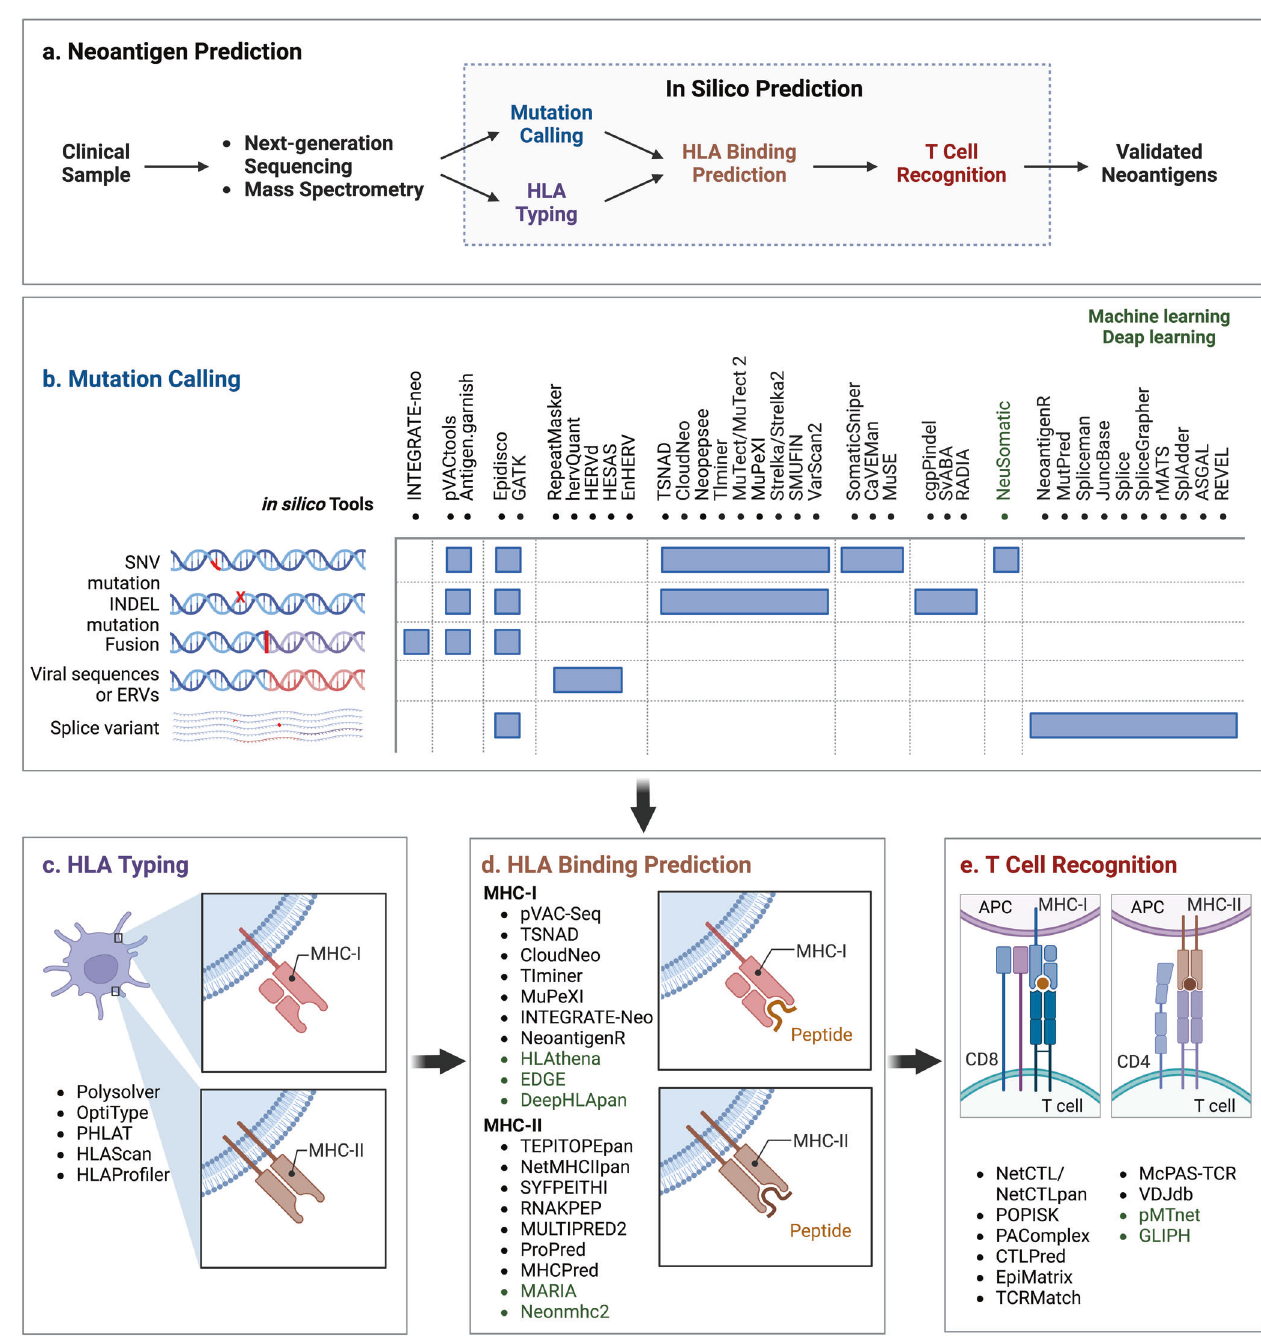
Fig. 3 Computational work fl ow for neoantigen prediction. Current available bioinformatic pipelines for neoantigen prediction from somatic mutations share four main computational modules: (i) HLA typing from tumor WGS, WES data and RNA-seq; (ii) mutant peptide calling using a set of somatic mutations and splicing variants; (iii) HLA binding prediction; and (iv) T cell recognition prediction. The in silico tools for mutation calling are listed as follows. Mutation calling: INTEGRATE-neo, 561 neoFusion, 80 pVACtools, 562 Epidisco, 563 GATK 564 and Antigen.garnish, 565,566 Spliceman, 567 MutPred, 568 REVEL, 569 rMATS, 570 pVACseq, 240 Neopepsee, 571 MuPeXI, 572 RepeatMasker, CloudNeo, 573 Tlminer, MuTect/MuTect2, Strelka/Strelka2, 574 SMUFIN, VarScan2, SomaticSniper, CaVEMan, MuSE, cgpPindel, SvABA, RADIA, NeuSomatic, NeoantigenR, MutPred, JuncBase, Splice, SpliceGrapher, rMATS, SplAdder, ASGAL, REVEL, TSNAD, 575 HERVd, 569 HESAS 576 and EnHERV, 577 hervQuant. 578 HLA typing: Polysolver, 254 OptiType, 253 HLAreporter, 579 PHLAT, 580 HLAScan, 260,581 HLAPro fi ler. 260 HLA binding af fi nity: NetMHCpan, 265 NetMHCIIpan4.0, 267 MixMHC2pred, 582 MARIA, 268 neomhc2, 583 pVAC-Seq, TIminer, HLAthena, DeepHLApan, TEPITOPEpan, NetMHCIIpan, SYFPEITHI, RNAKPEP, MULTIPRED2, ProPred, MHCPred, MARIA, Neonmhc2, EDGE. 38,238 T cell recognition: NetCTL/NetCTLpan, POPISK, PAComplex, CTLPred, EpiMatrix, TCRMatch processing and presentation, including NetChop, NetCTL and Prediction of HLA binding and neoantigen presentation NetCTLpan 264,265 (Fig. 3). The prediction capacity is actively Numerous computer prediction tools have been created for the in silico discovery of neoantigens based on MHC molecule improved by incorporating HLA-ligandome data into machine Signal Transduction and Targeted Therapy (2023)